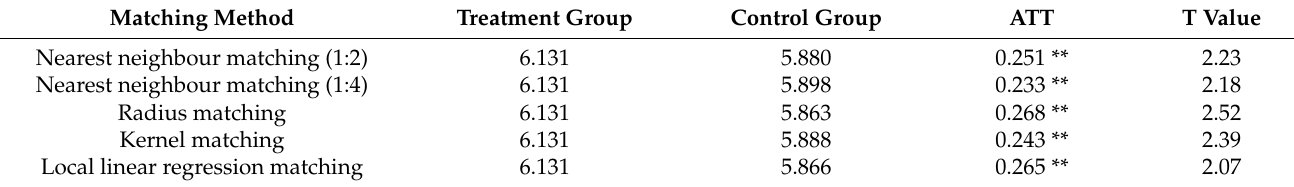
Table 5. Results for different propensity score matching